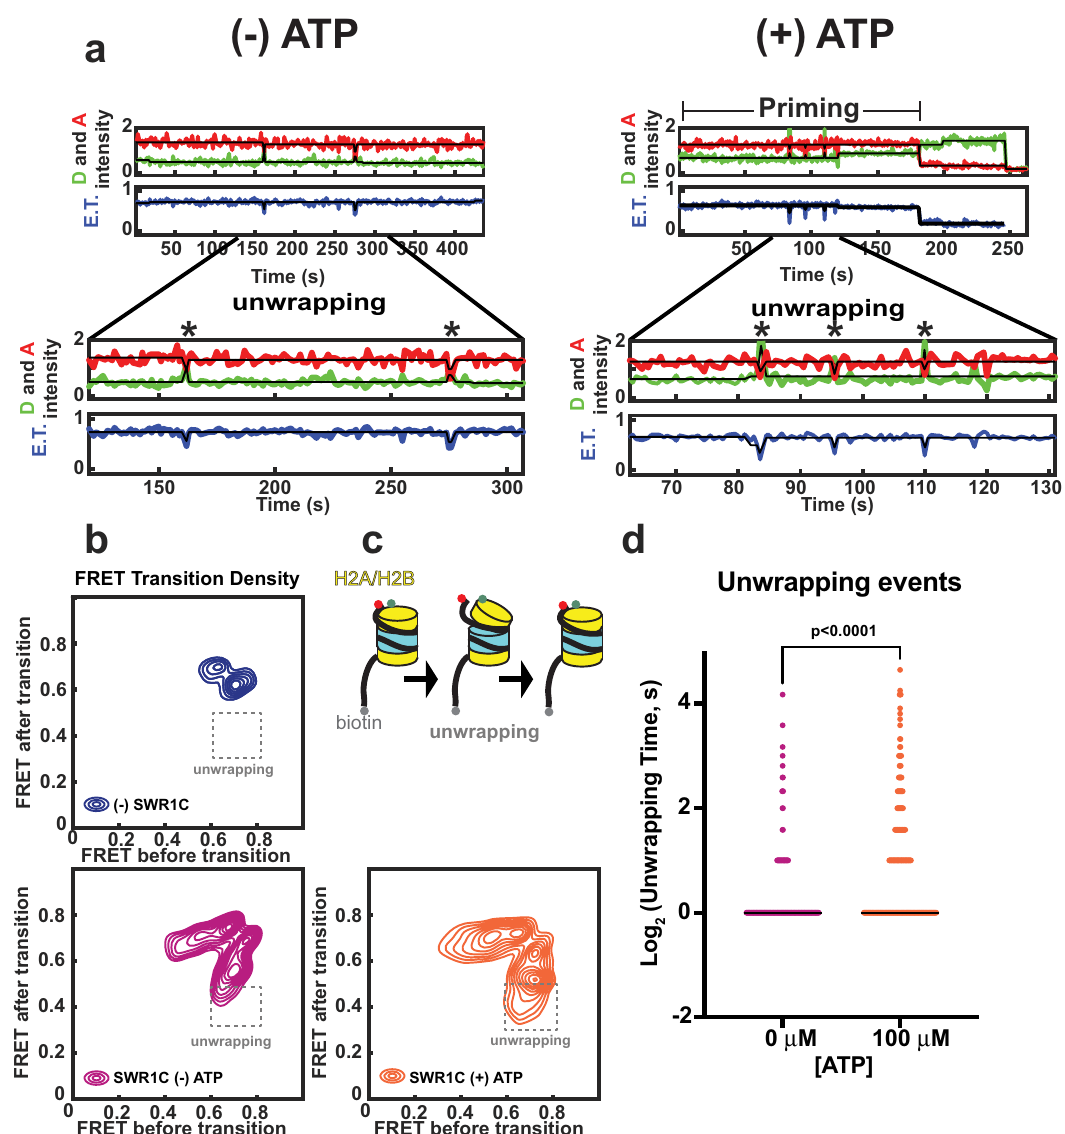
Fig. 4 | The frequency of SWR1C-induced nucleosome unwrapping increases withtheadditionofATP.a Exampletrajectoryhighlightingunwrappingevents(*) thatoccurintheprimingphasefor0 μ MATP(leftside)and100 μ MATP.TheCy3B donor fl uorophore was excited, and donor emission (green) and ATTO 647N acceptor emission (red) were recorded (top panel) and used to calculate energy transfer ef fi ciency (blue, bottom panel). b Priming phase E.T. transition density plot. The intensity of E.T. transitions are normalized to the total observation win- dow, for nucleosome substrate lacking SWR1C and ATP ( N =73 nucleosomes with aninitial E.T. state > 0.6 from 4 replicates) (blue), and for nucleosome substrate in